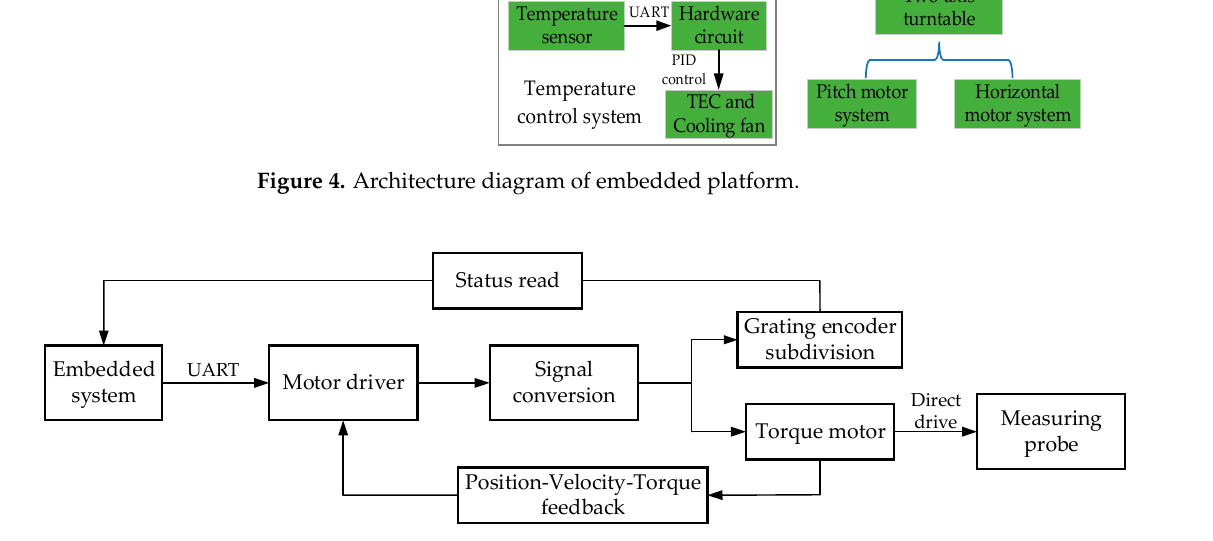
Figure 5. Schematic illustration of turntable control.